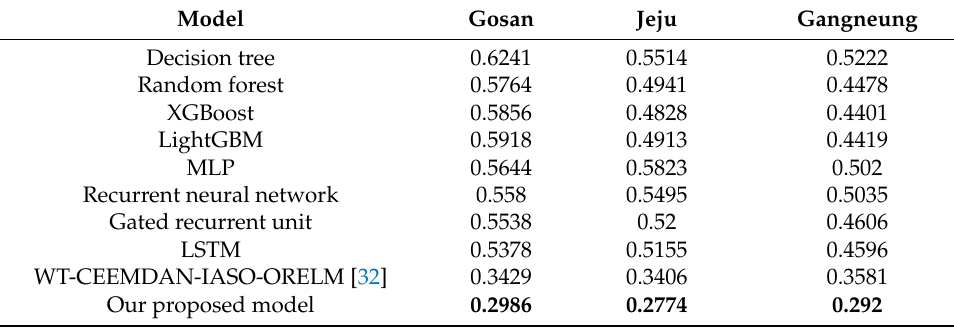
Table 6. RMSE results of solar radiation forecasting models in three regions (MJ/m 2 ).